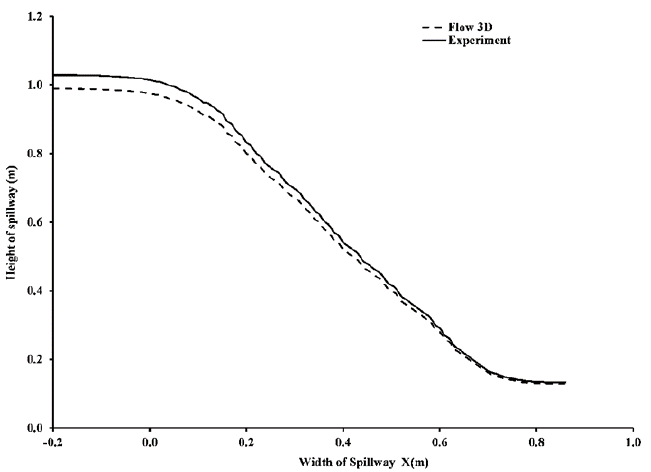
Figure 8. Free surface elevation comparison.